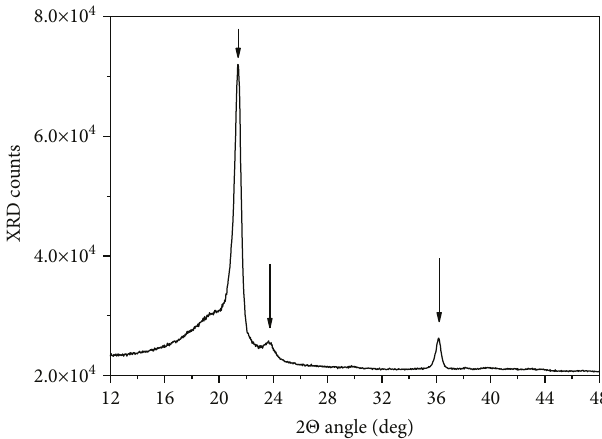
λ = 1 5414 Å). The arrow indicates the LDPE re fl ection α radiation,